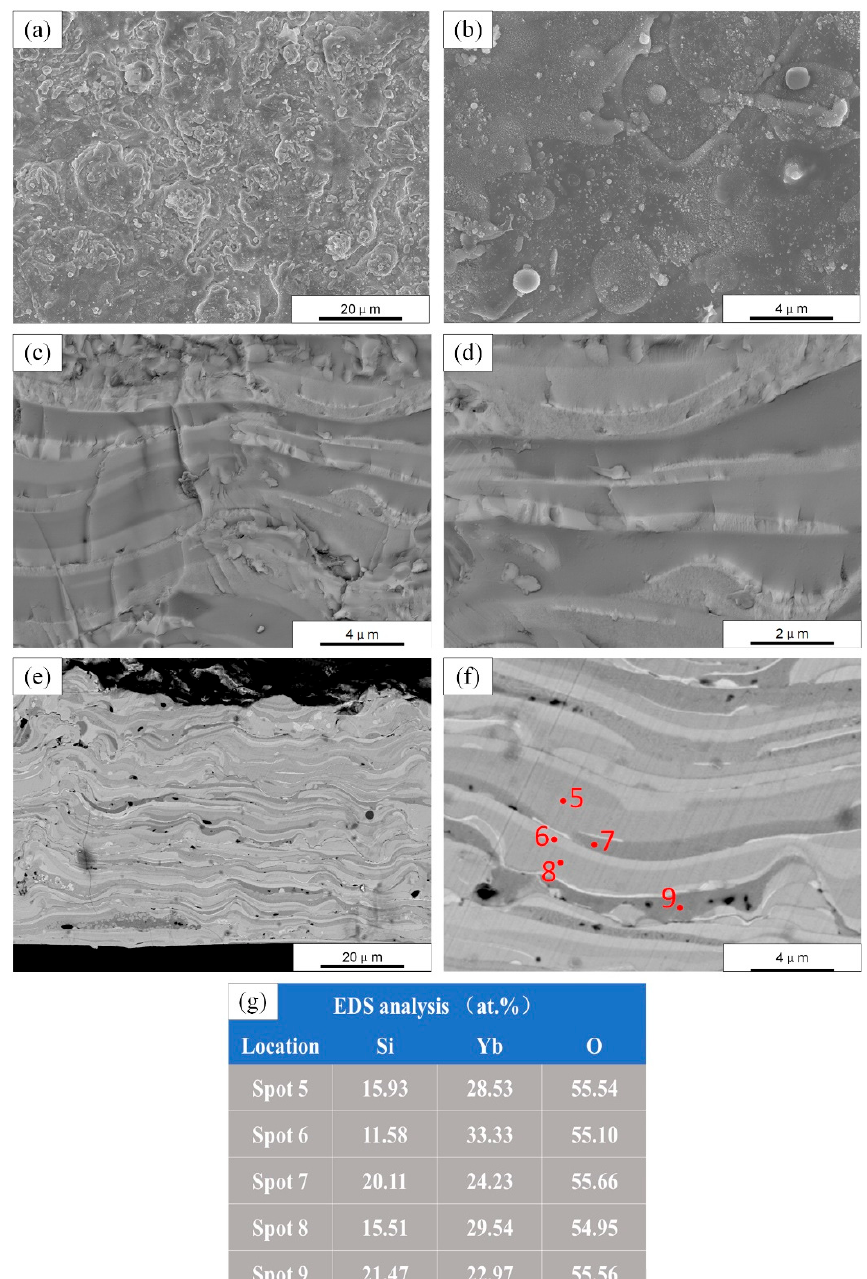
Figure 5. SEM micrographs of as-sprayed ytterbium silicate top-coats prepared by parameter set B: ( a,b ) Surface morphology; ( c,d ) Fracture morphology; ( e,f ) Cross section by back-scattered electron; and ( g ) EDS analysis of five spots in ( f ).